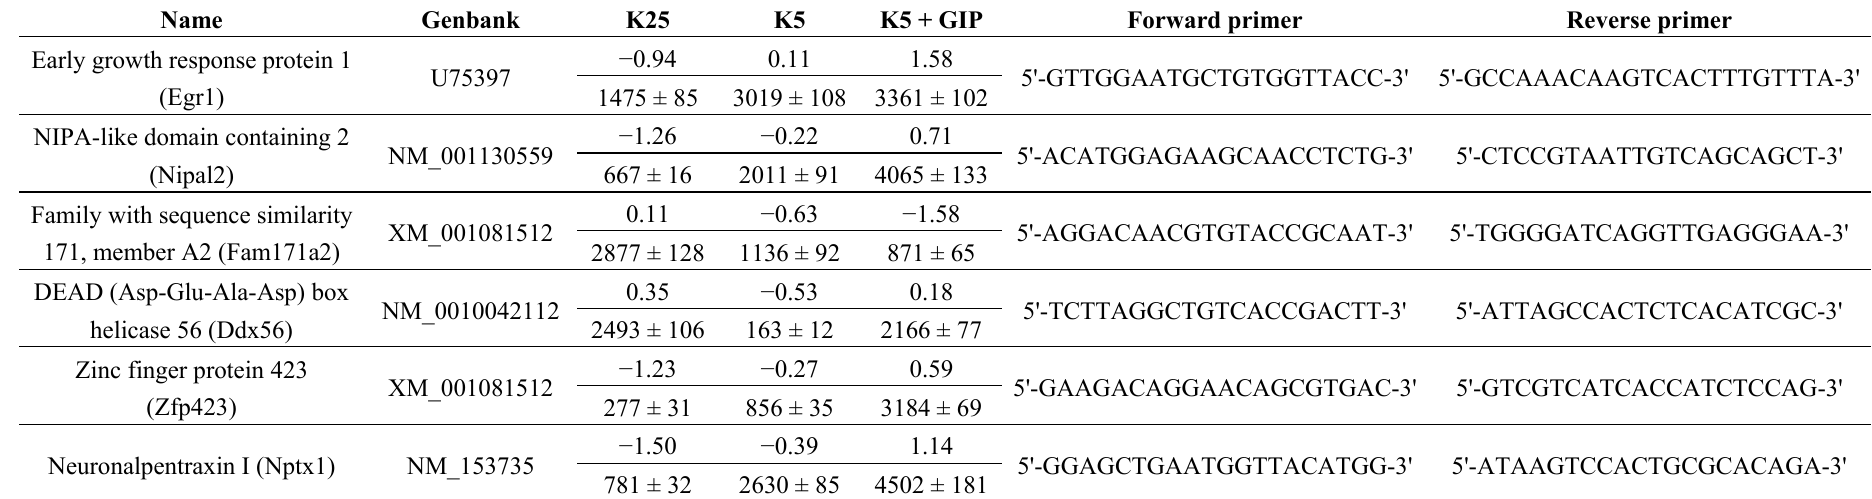
Table 1. Validation of microarray data by real-time quantitative RT-PCR. Real-time PCR was used to validate the change in gene expression detected by microarray and to support the survival effects of Gip on